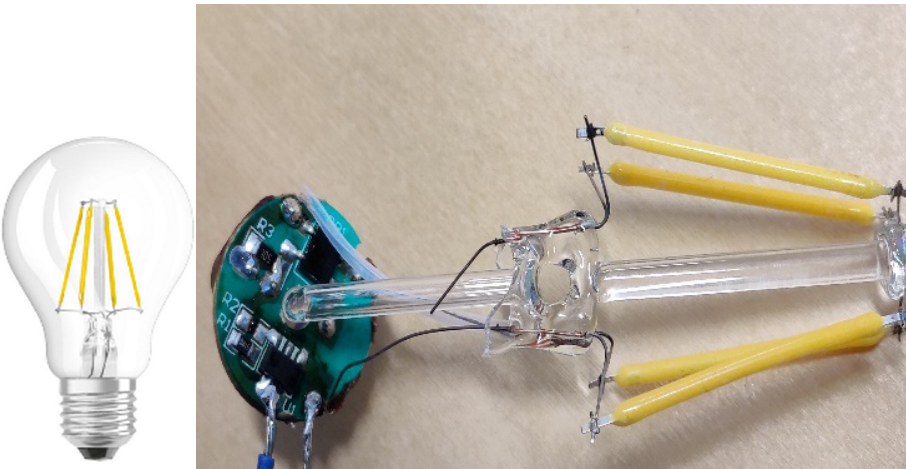
Figure 7. A Type D lamp ( left ) and the components inside the lamp ( right ).